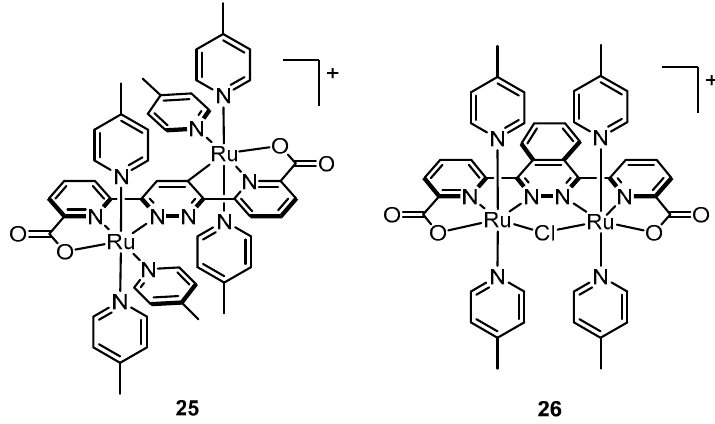
Figure 12. Dinuclear Ru catalysts with anionic groups.